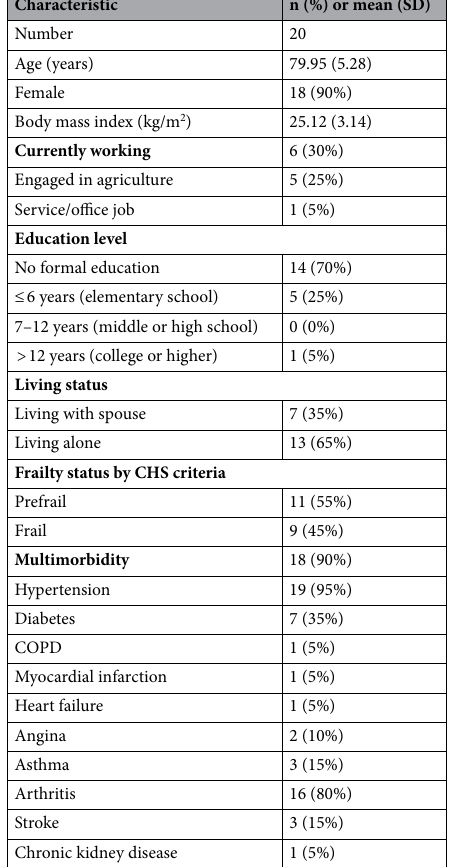
Table 1. Basic characteristics of the study participants. CHS cardiovascular health study, COPD chronic obstructive pulmonary disease, SD standard